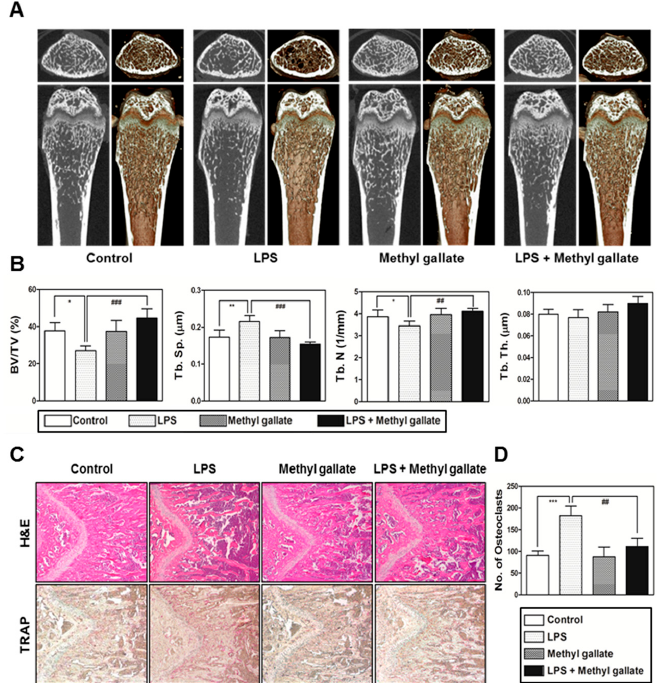
Figure 4. Methyl gallate restores the lipopolysaccharide (LPS)-mediated bone erosion mice model. ( A ) Mice were euthanized on day 8 after first LPS injection and 2D or 3D radiographs of the